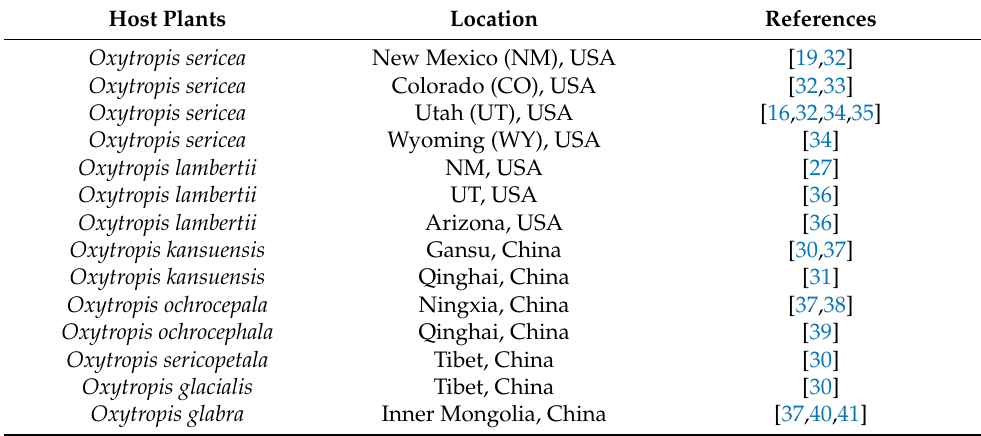
Table 2. Formally recognized Oxytropis A . sect. Undifilum associations and their typical location. Host